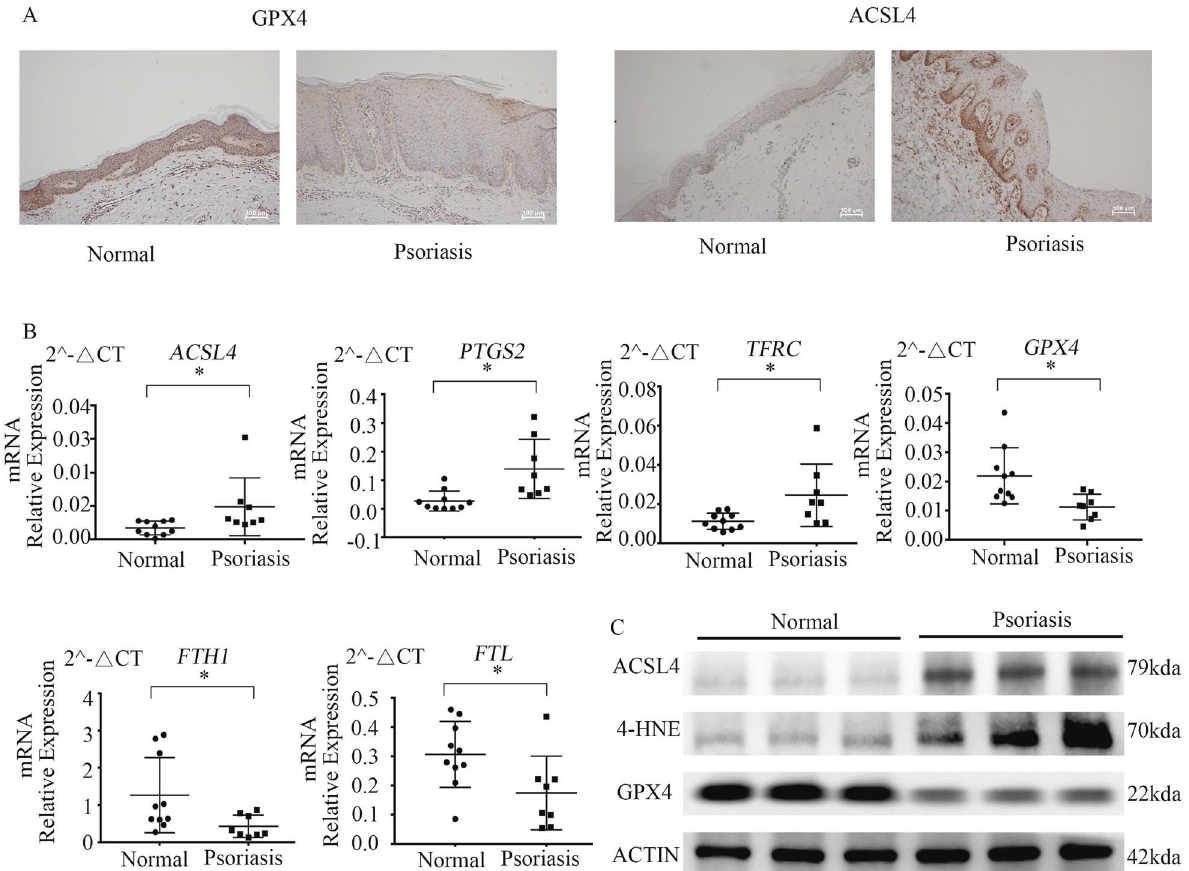
Fig. 1 Ferroptosis is executed in psoriasis lesions. A Representative immunohistochemical staining for GPX4 and ACSL4 expression in normal lesions and psoriasis lesions. The white scale bar was 100 μ m. B mRNA expression of ACSL4 , PTGS2 , TFRC , GPX4 , FTH1 , and FTL in normal samples ( n = 10) and psoriatic lesions ( n = 8). Data were normalized to actin mRNA expression. * P < 0.05. C Western blot for GPX4, 4-HNE- modi fi ed protein levels, and ACSL4 protein in normal lesions and psoriasis lesions. Actin was used as the loading control. ACSL4 acyl-CoA synthetase long-chain family member 4, GPX4 glutathione peroxidase 4, 4-HNE 4-hydroxynonenal, PTGS2 prostaglandin-endoperoxide synthase 2, TFRC transferrin receptor, FTL ferritin light chain, FTH1 ferritin heavy chain